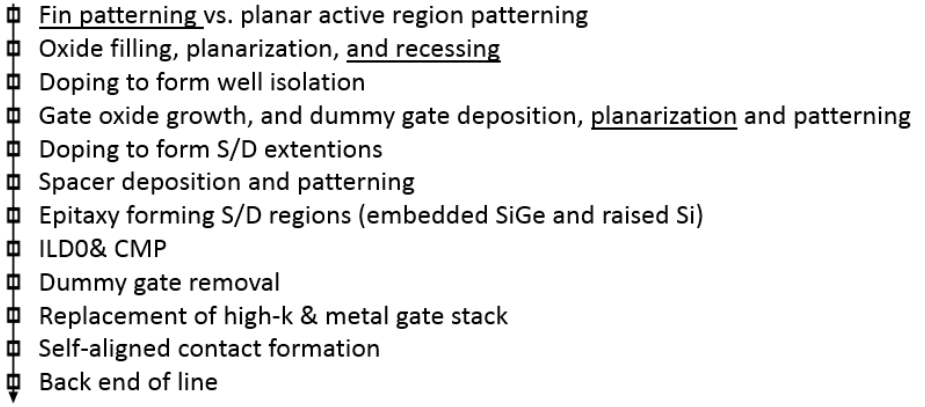
Figure 5. Process flow for the bulk FinFETs or planar transistors. The FinFETs process are underlined [36].